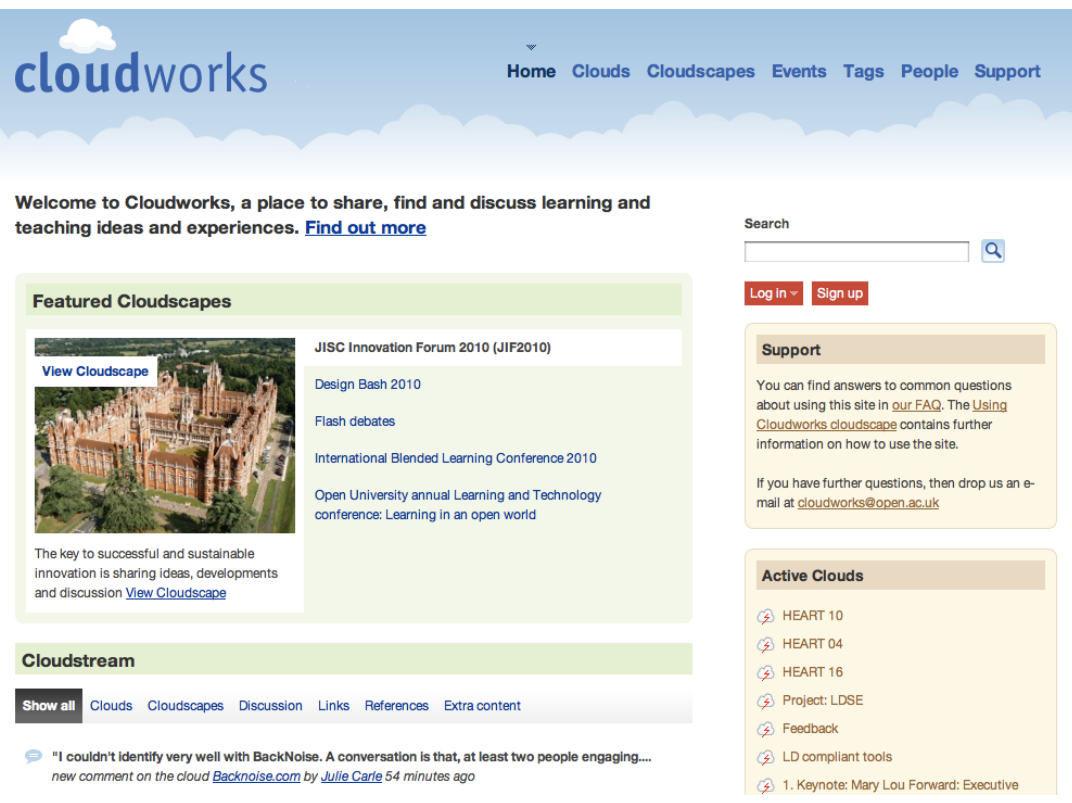
Figure 1. Screenshot of the Cloudworks homepage, July